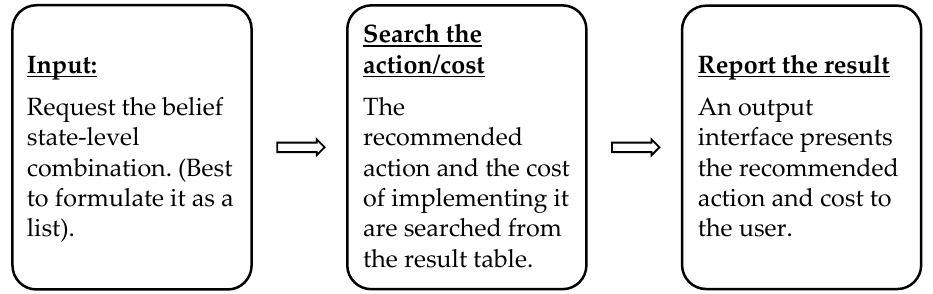
Figure 2. Input/output interface for reporting results.